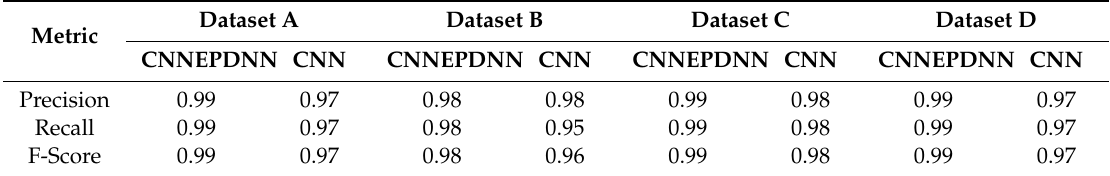
Table 5. F-Score results obtained with CNN and CNNEPDNN.